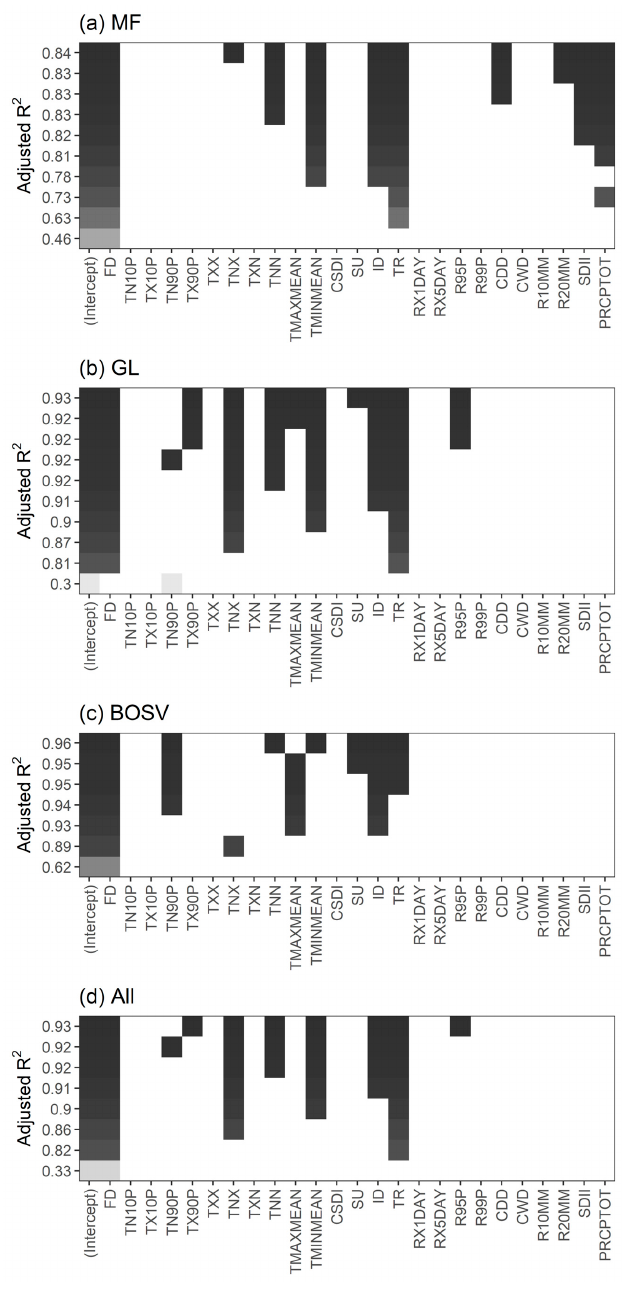
Figure 5. Best subsets based on adjusted R 2 for (a) mixed forests (MF), (b) grasslands (GL), (c) barren or sparsely vegetated land (BOSV), and (d) all three vegetation types (All).